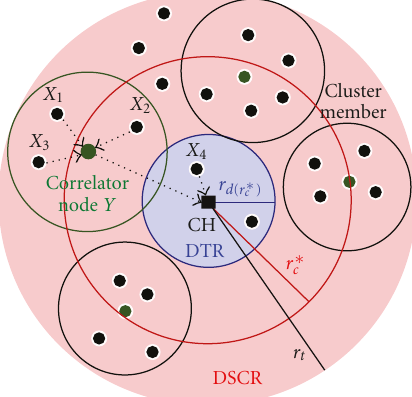
Figure 3: A correlator node Y is illustrated with its members X 1 , X 2 , guides the formation of and X 3 . The ideal correlator radius r ∗ c such rate assignment groups in Distributed Source Coding Region ( DSCR ) shaded in red color. The cluster members such as node X 4 in blue colored Direct Transmission Region ( DTR ) send data directly to the